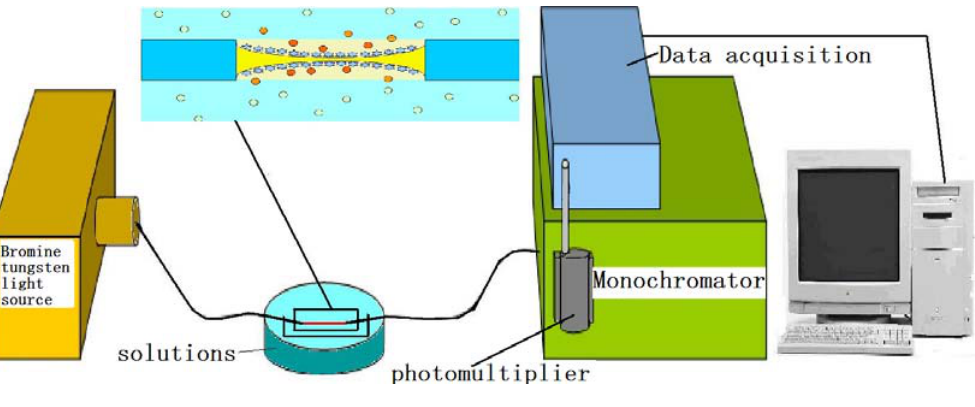
Figure 6. Diagram of the LSPR transmission spectrum measurement